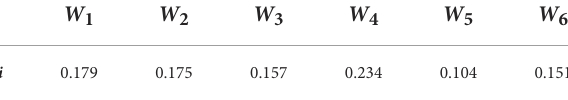
TABLE 8 The original weights of all attributes.